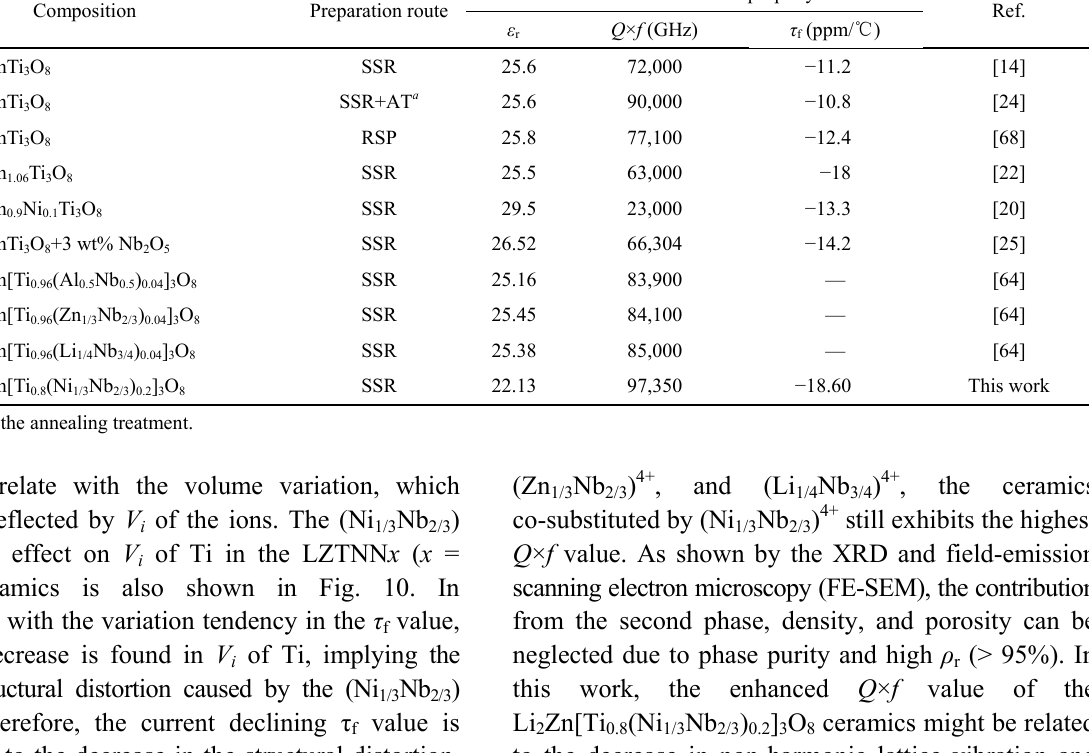
Table 5 Some related research results of Li 2 ZnTi 3 O 8 -based ceramics obtained by different processes Composition Preparation